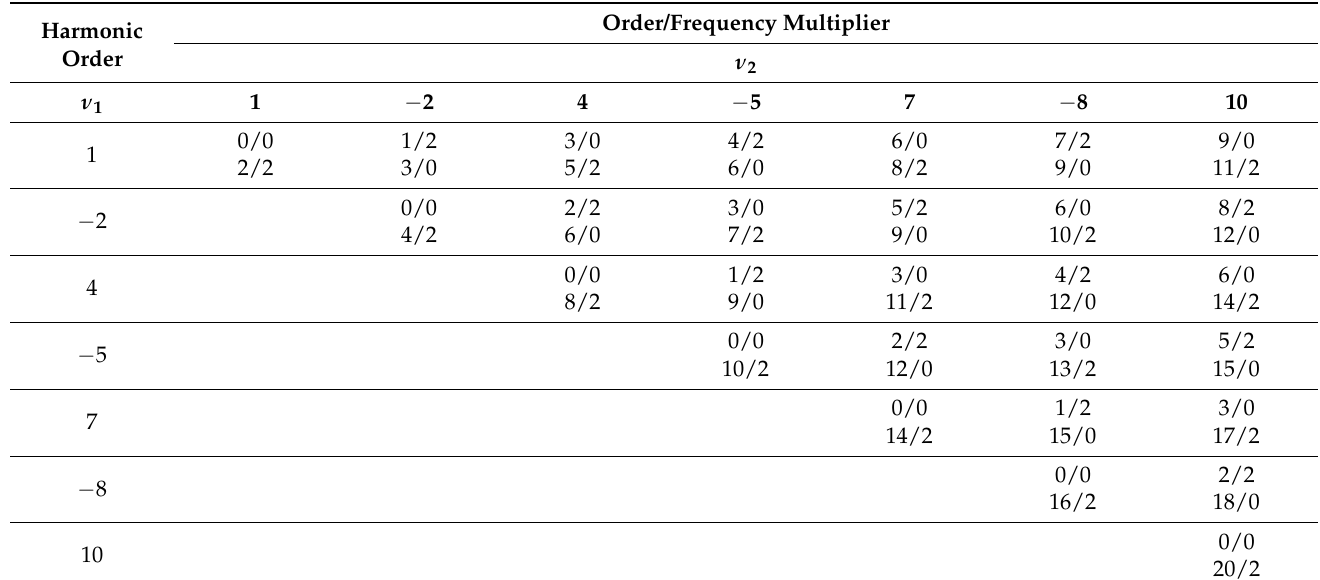
Table 4. The stator armature magnetic field alone generates radial electromagnetic force.